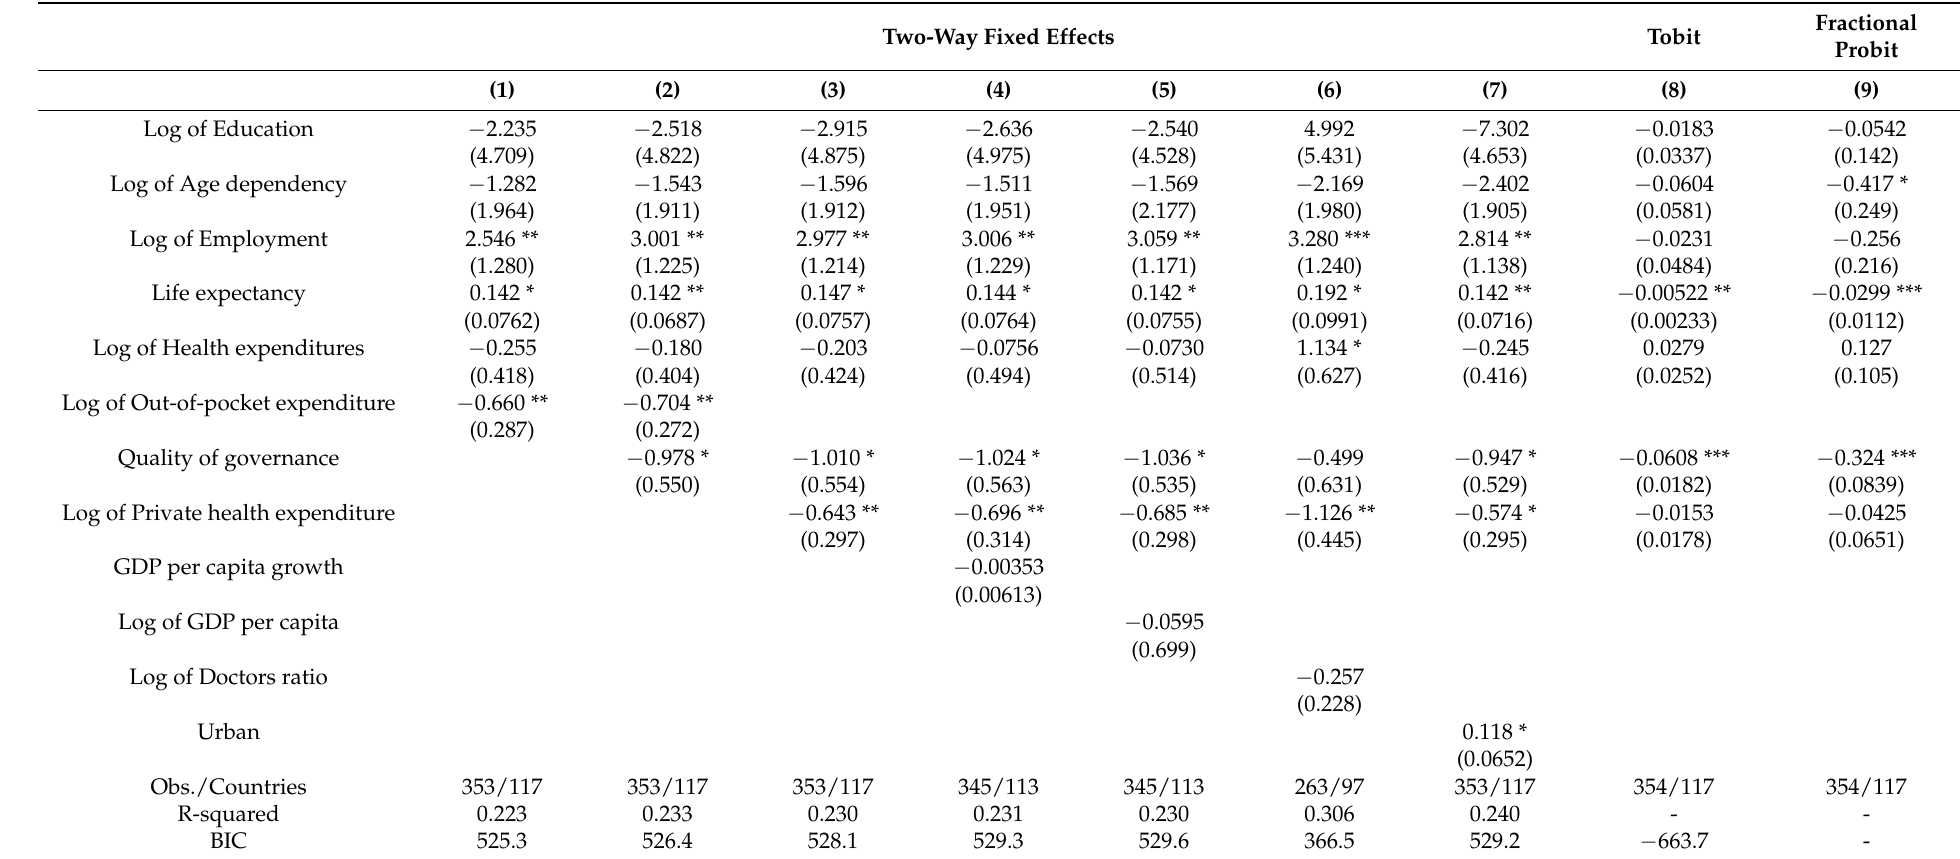
Table 1. Panel estimation of the role of formal institutions in explaining bribes in the health sector,